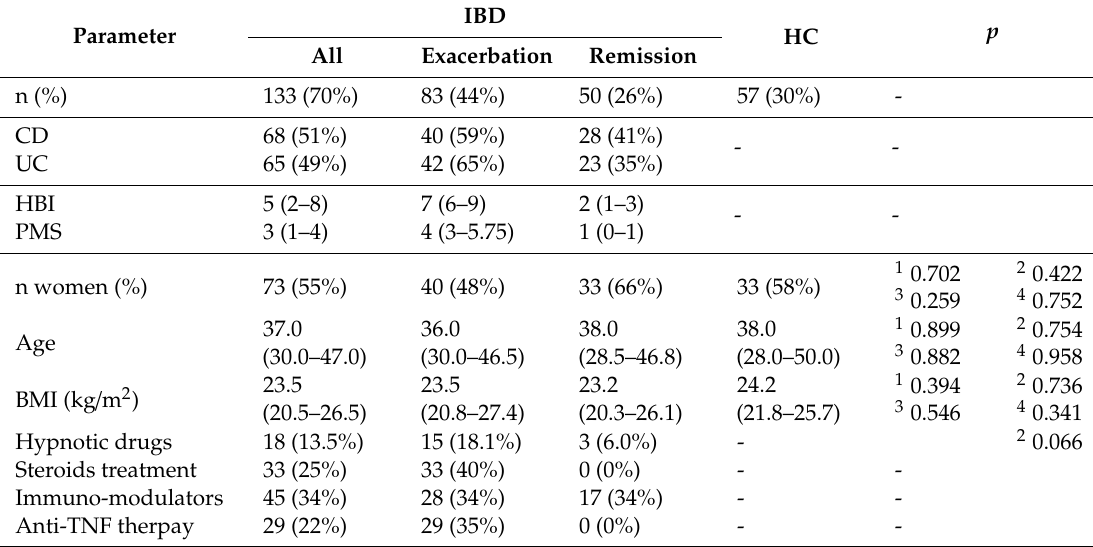
Table 1. Characteristics of the